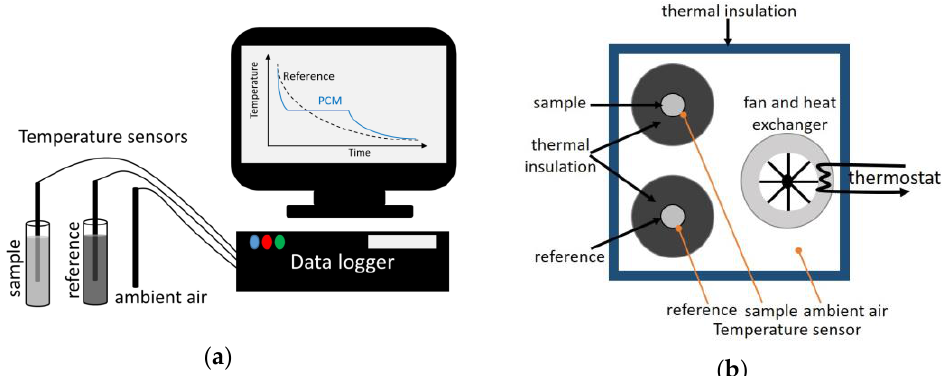
Figure 2. Schematic of T-history set-up adapted from [18]: ( a ) early T-history set-up from 1999; ( b ) the modified set-up from 2006 fabricated at the Bavarian Center for Applied Energy Research (ZAE Bayern).